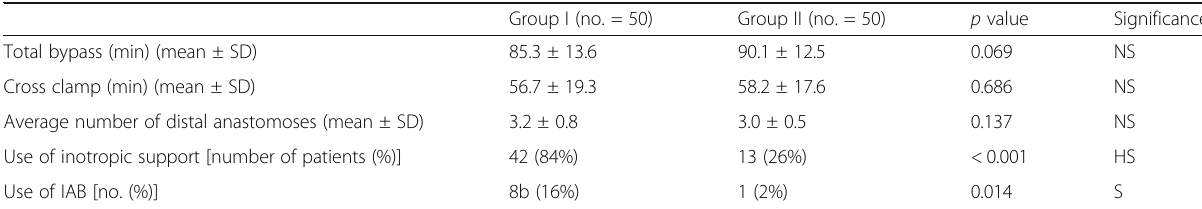
Table 2 Intraoperative